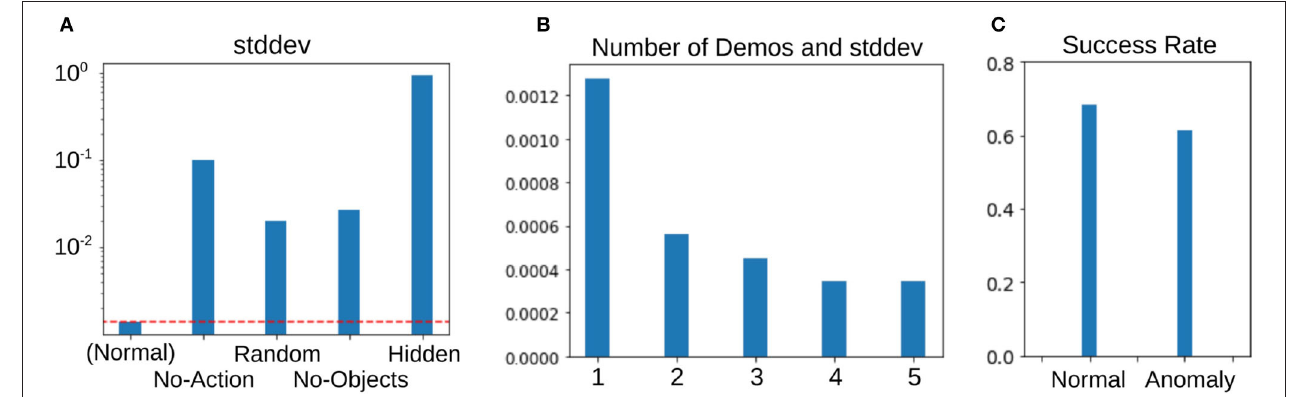
FIGURE 5 | Experimental results about task uncertainty. (A) Average standard deviation of the task-embedding distribution using the original and synthesized out-of-distribution demonstrations as in Figure 4 . (B) Average standard deviation with different number of demonstrations. (C) Comparison of performance using the demonstrations with normal and anomalous standard deviations during